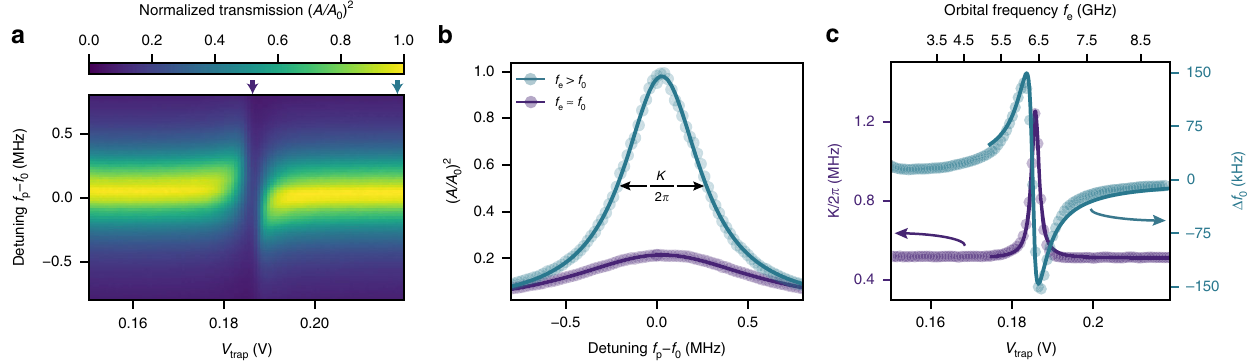
(cid:3) f Fig. 4 Single electron resonator spectroscopy. a Normalized transmission amplitude as function of trap voltage and microwave probe detuning f 0 . p = 0.184 V (purple circles) the electron is resonant with , indicated by arrows on the horizontal axis in a . For V b Resonator spectra for two values of V trap trap ¼ 0 : 23 V the electron is far off-resonant (turquoise circles). The resonant trace illustrates the sensitivity of our device to a the cavity, whereas for V trap single electron. c Cavity resonance frequency shift (turquoise circles, right axis) and resonator decay rate (purple circles, left axis) obtained by fi tting the Lorentzian resonator spectra from a . The solid turquoise line is a fi t to a model that yields a coupling strength near resonance of g = 2 π ¼ 4 : 8 ± 0 : 3 MHz and total electron linewidth γ = 2 π ¼ 77 ± 19 MHz. The top horizontal axis displays how the electron orbital frequency varies as function of V , and shows trap ¼ 6 : 4 GHz) at V ¼ 0 : a crossing with the resonator ( f e trap